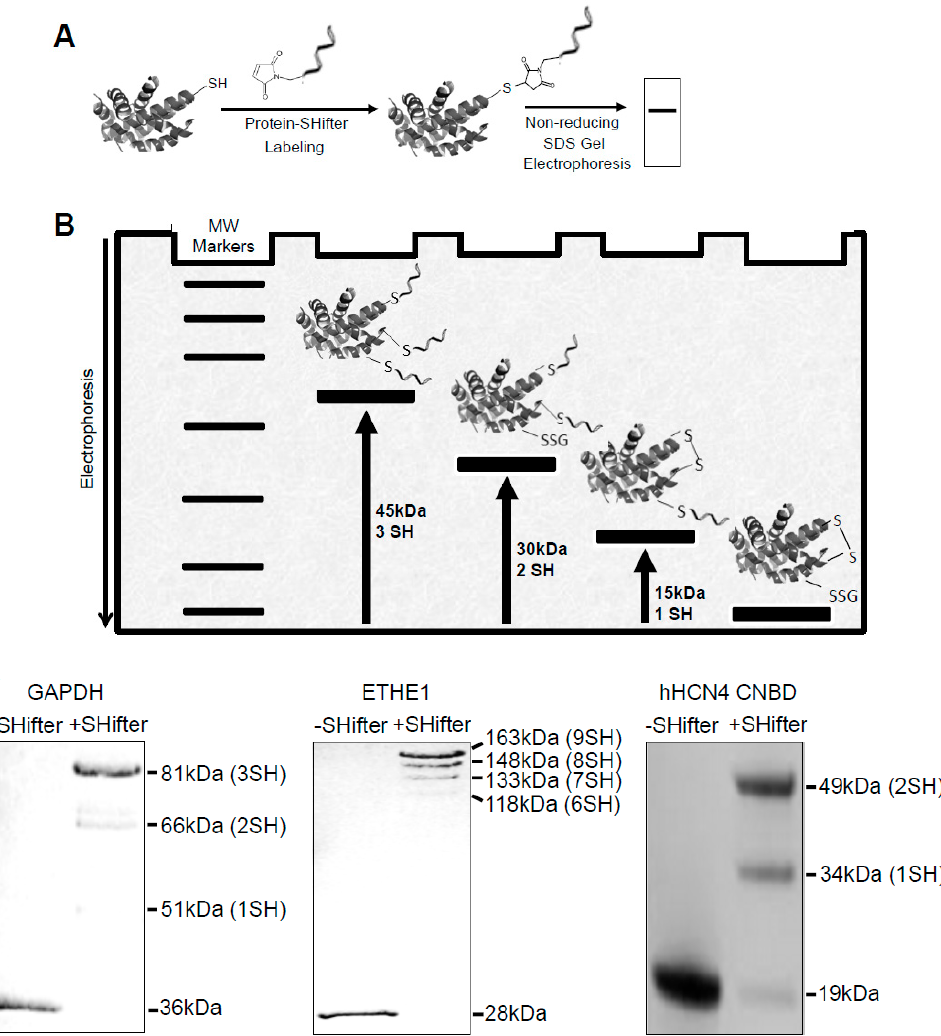
Figure 1. - SulfoBiotics - Protein Redox State Monitoring Kit. ( A ) The principle of the - SulfoBiotics - Protein Redox State Monitoring Kit. A free protein thiol group was labeled with the Protein-SHifter that contained maleimide with a high affinity toward reduced cysteine. Samples were then electrophoresed and stained. ( B ) For each Protein-SHifter bound to a protein molecule, a 15-kDa shift was observed in the electrophoresis. ( C ) Examples of the use of the - SulfoBiotics - Protein Redox State Monitoring Kit to determine the thiol redox state of recombinant proteins.